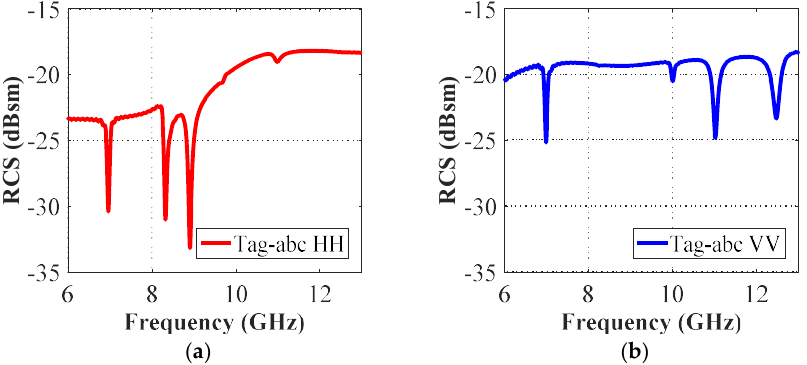
Figure 8. Co-polar RCS simulation results of tag-abc ( a ): Co-polar HH RCS responses; ( b ) Co-polar VV RCS responses.